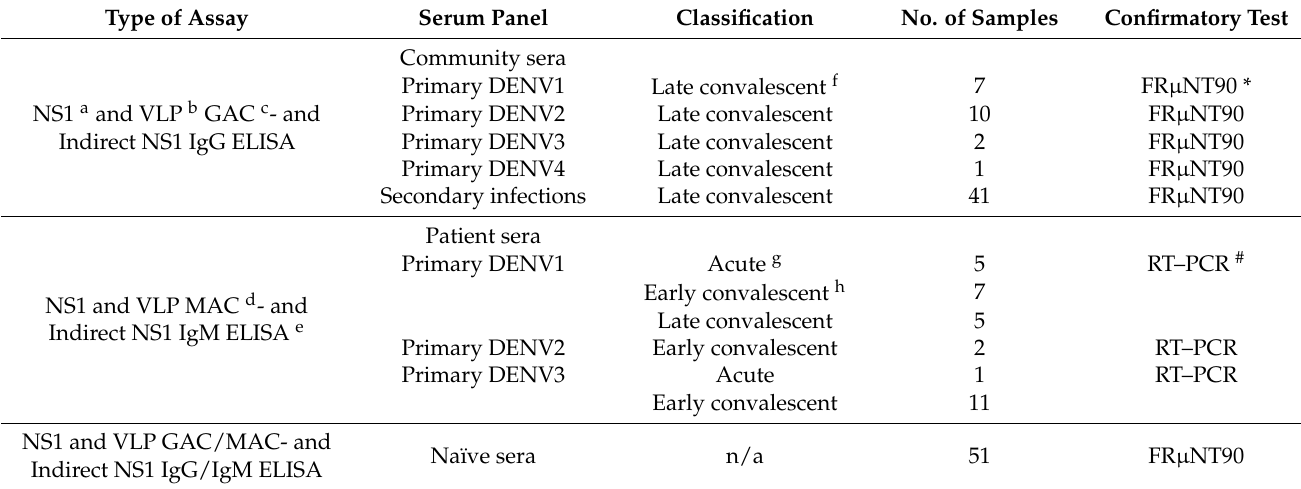
Table 1. Characteristics of the serum panels used in this